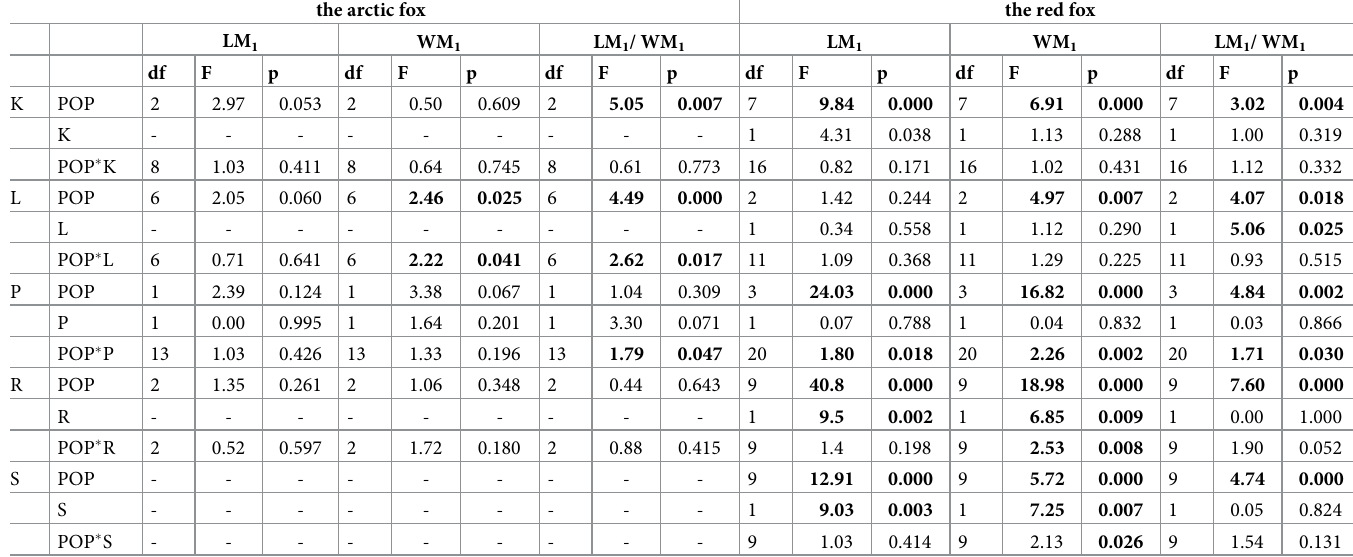
Table 2. Size variation of the first lower molar (M 1 ) in the arctic and red foxes according to population division (POP), morphotype differentiation (morphotype groups: K, L, P, R, S), and interactions between both factors (POP � K; POP � L; POP � P; POP � R; POP � S). Bold letters indicate statistical significances (p < 0.05) of the